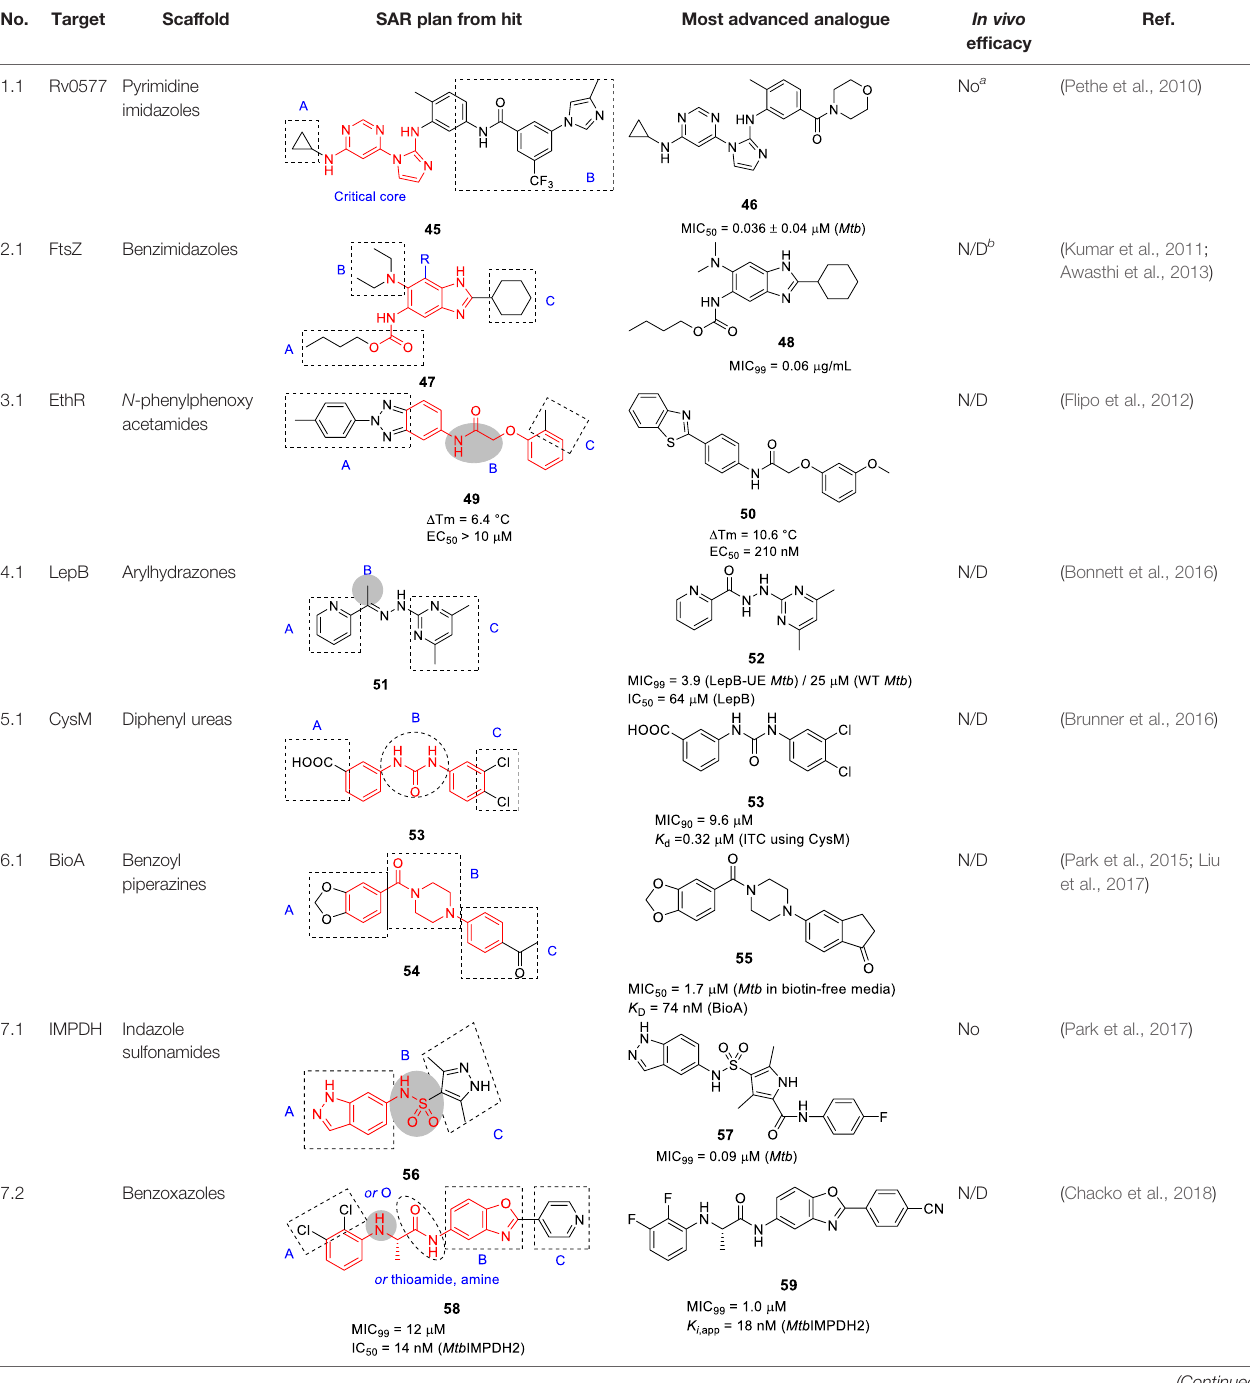
TABLE 4 | Antitubercular agents inhibiting other mycobacterial targets. No.